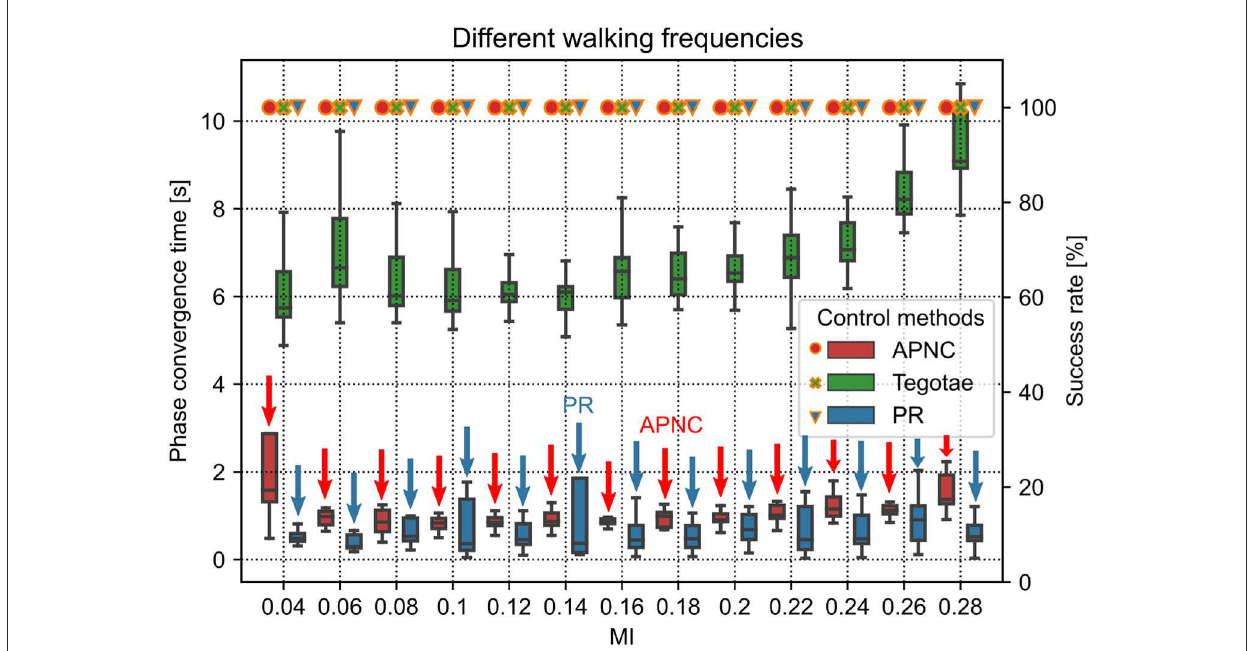
FIGURE4 Phase convergence time (represented by the boxes along with the left axis) and success rate (represented by the marks along with the right axis) of the robot performing self-organized locomotion under three different control methods (APNC, Tegotae, and PR) and different MI values (corresponding to different walking frequencies). Small and large MI values indicate low and high walking frequencies, respectively. The success rate is defined as the ratio of successful phase convergences to total trials (i.e., 20). The red and blue arrows indicate the APNC and PR.